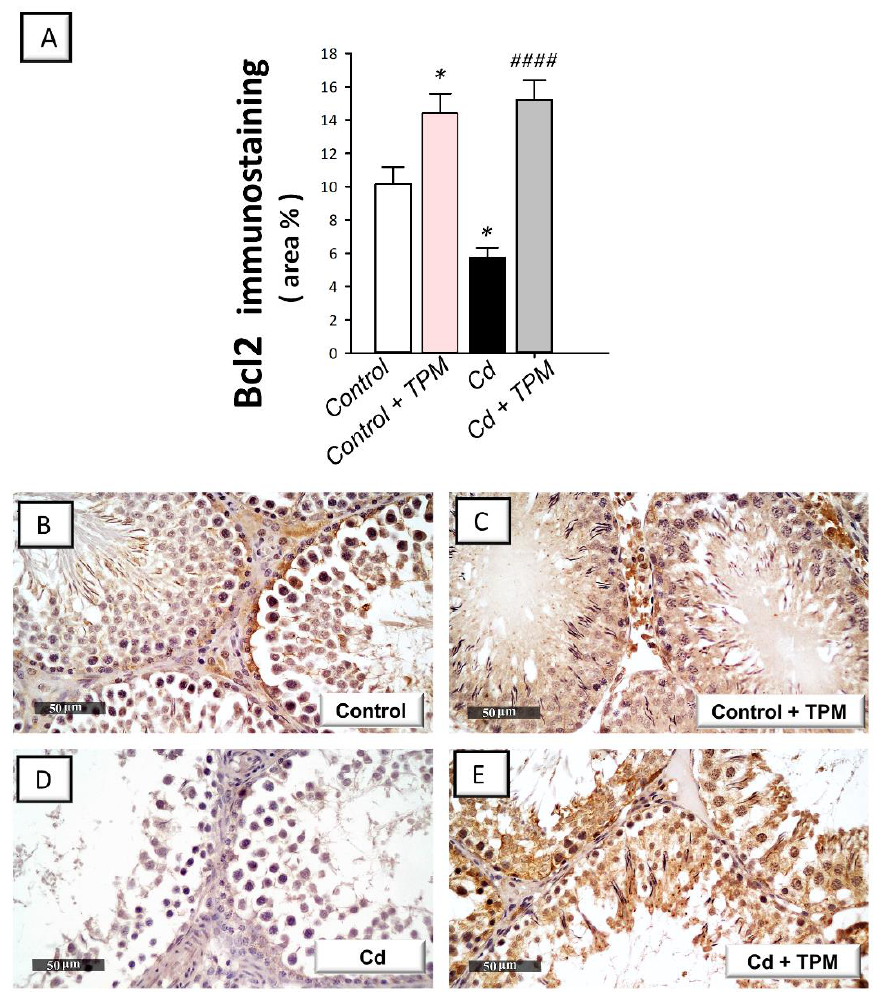
Figure 6. Effect of cadmium and/or topiramate on the immunostaining of the anti-apoptotic Bcl-2 in testes of rats. The co-treatment with topiramate enhances the quantification of testicular Bcl-2 protein expression [H (3, 20) = 18.25, p < 0.0001] ( A ) that were lowered by cadmium administration. The determination of Bcl-2 protein expression was carried out by the detection of its immunostaining (brown color) in the testes of animals at 400× magnification. The slides were counterstained with hematoxylin. ( A ) Quantitative analysis of Bcl-2 immunostaining. This was demonstrated as the area % of the brown immunostaining relative to the microscopic field’s whole area (in each section, six non-overlapping fields were investigated). Results are demonstrated as the mean ± standard error of the mean (SEM). * p < 0.05 signifies statistical significance versus the control group; #### p < 0.001 signifies statistical significance versus the cadmium chloride-treated group. ( B , C ) Intense expression in the control and topiramate-treated control groups, respectively. ( D ) Suppressed immunostaining of Bcl-2 in cadmium-intoxicated group. ( E ) Topiramate upregulated the protein expression of Bcl-2 as indicated by increased immunostaining. Bcl-2, B cell lymphoma-2. TPM, topiramate; Cd, cadmium chloride.